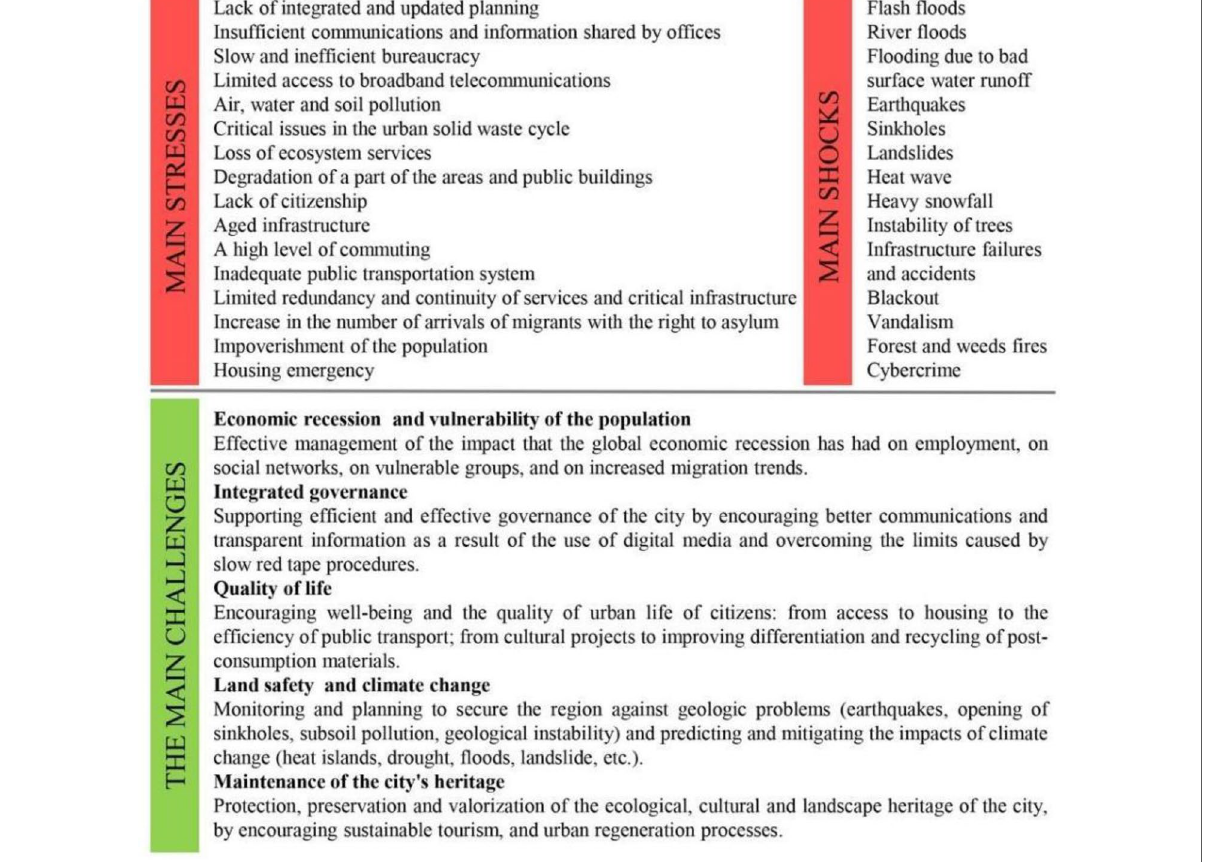
Fig. 5 Rome: shocks, stresses, and challenges as perceived by the involved